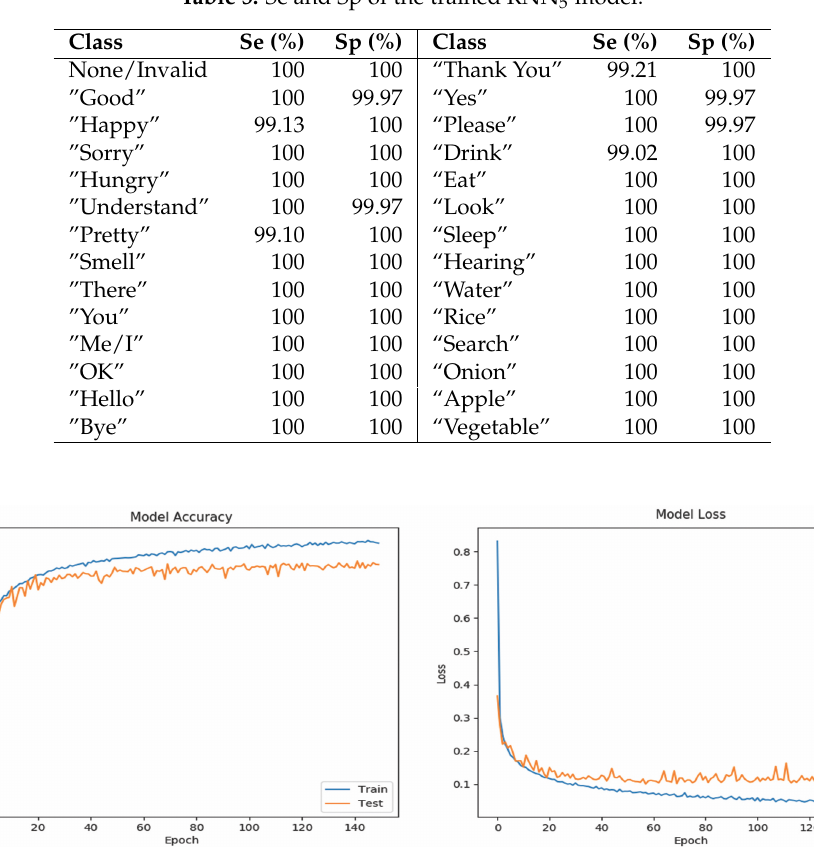
Table 5. Se and Sp of the trained RNN 5 model.